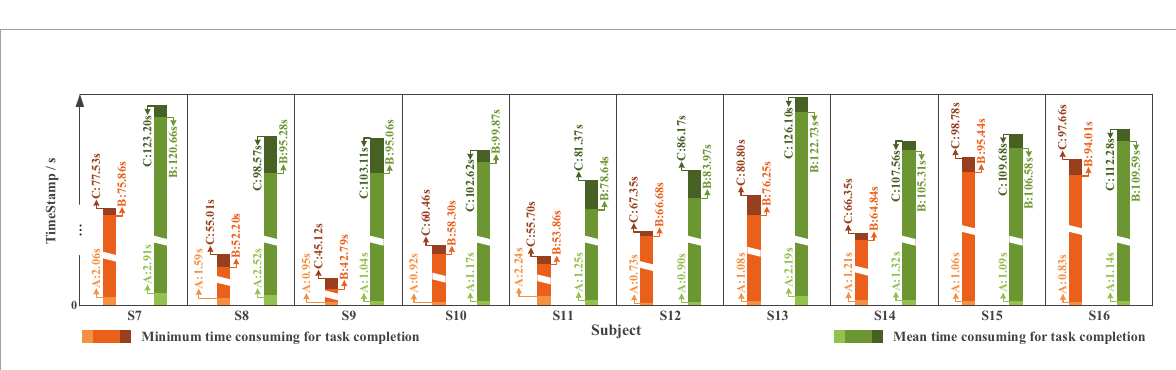
FIGURE21 The time cost in Task one with slight-facial expression (sFE)-paradigm, where the timestamp A corresponds to “System Turn ON,” the timestamp B corresponds to “Gripper Open” and the timestamp C corresponds to “System Turn OFF” (as demonstrated in Figure 17 ).